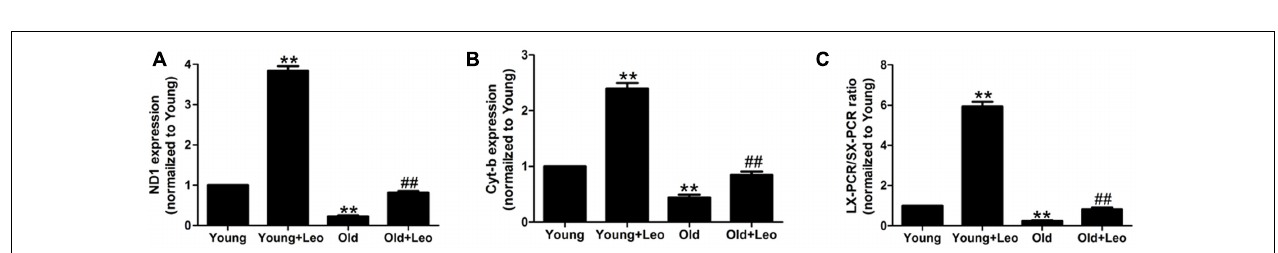
FIGURE 6 | Effects of aging and leonurine on mitochondrial damage in ischemic muscles. (A–C) Quantification of mRNA expression of mitochondrial component, nicotinamide adenine dinucleotide dehydrogenase subunit 1 (ND1; A ) and cytochrome b (Cyt-b; B ) assessed by quantitative realtime PCR. (C) Quantification of Long-extension (LX)-PCR and short-extension (SX)-PCR of mtDNA ratio. Data are mean ± SEM. ∗∗ p < 0.01 vs. young group; ## p < 0.01 vs. old group. n = 6–8/group.